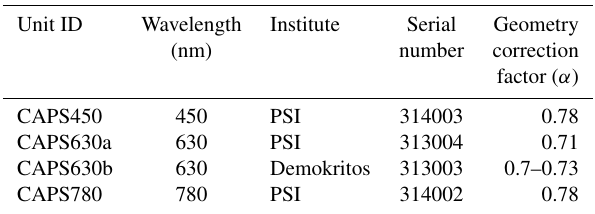
Table 2. CAPS PMssa instrument units that were used in the present